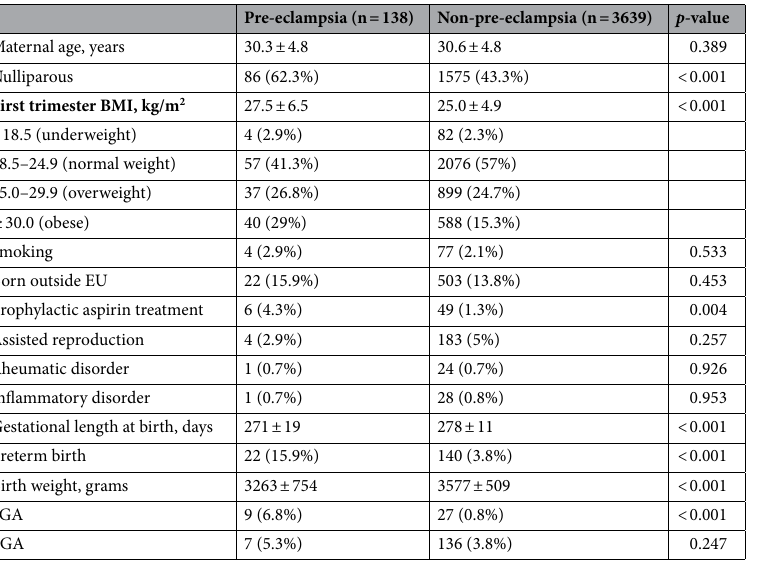
Table 1. Demographic and clinical variables of the study population. Data presented as mean ± SD or n (%). BMI = body mass index; SGA = small for gestational age (birth weight below the third percentile); LGA = large for gestational age (birth weight above 97th percentile). Statistical analyses by independent t-test or Chi-square